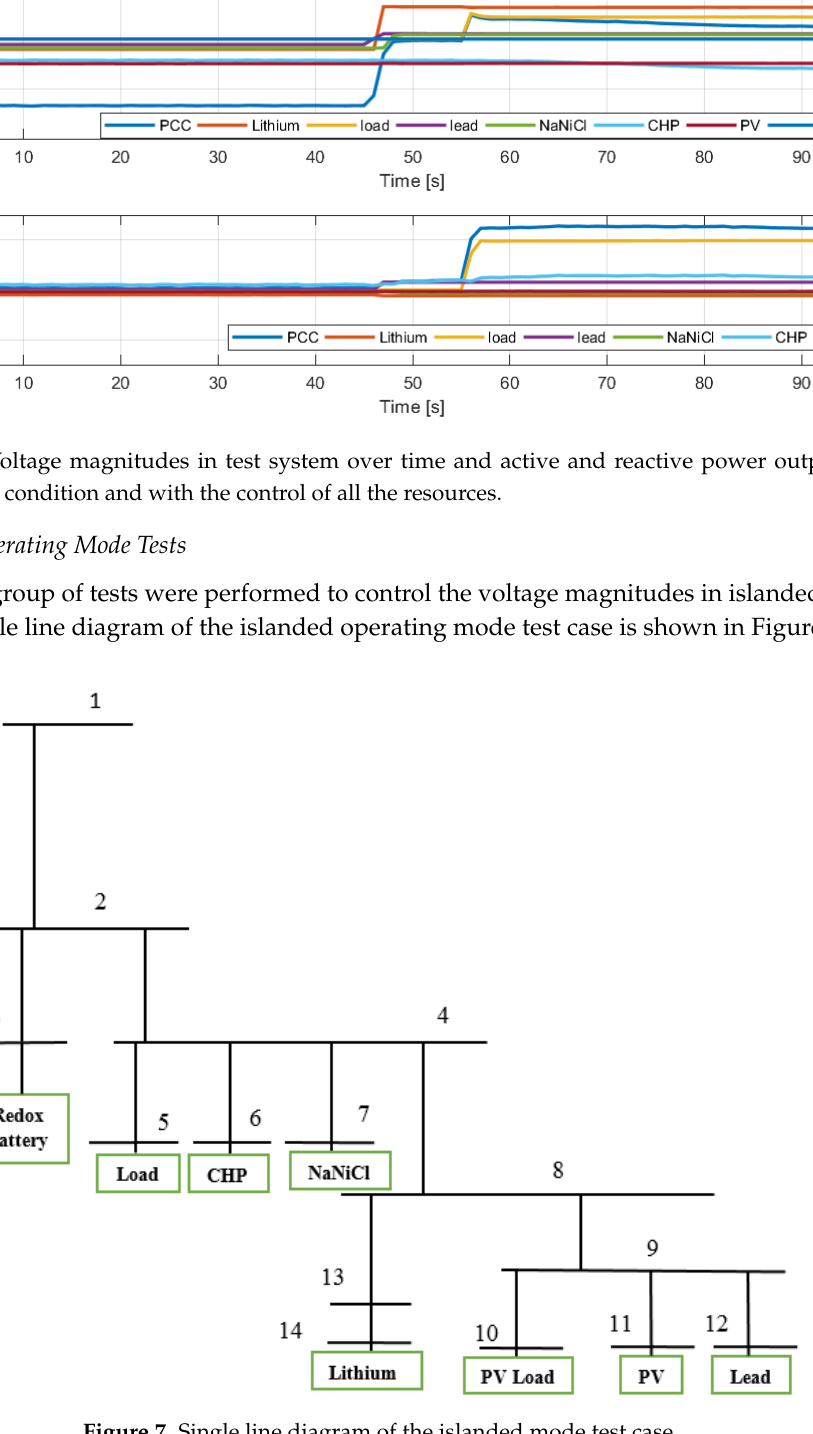
Figure 7. Single line diagram of the islanded mode test